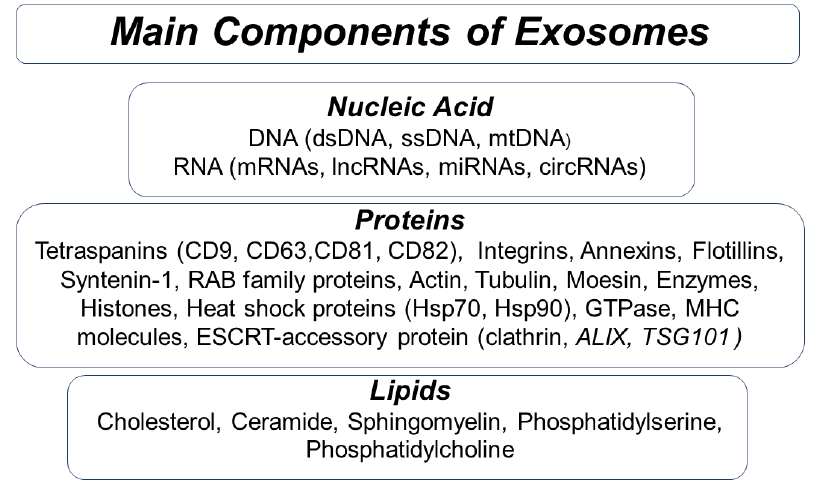
Figure 2. Molecular composition of exosomes. These vesicles contain different cell surface proteins, membrane transport and fusion, antigen presentation, signal transduction, targeting, and adhesion proteins. Several molecules of nucleic acids and lipids are present.